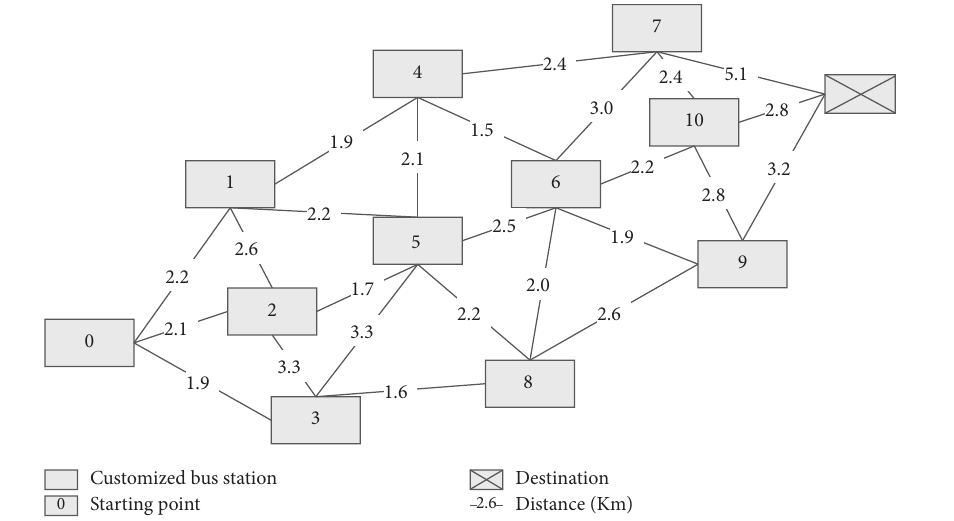
Figure 2: Schematic of stop distances.